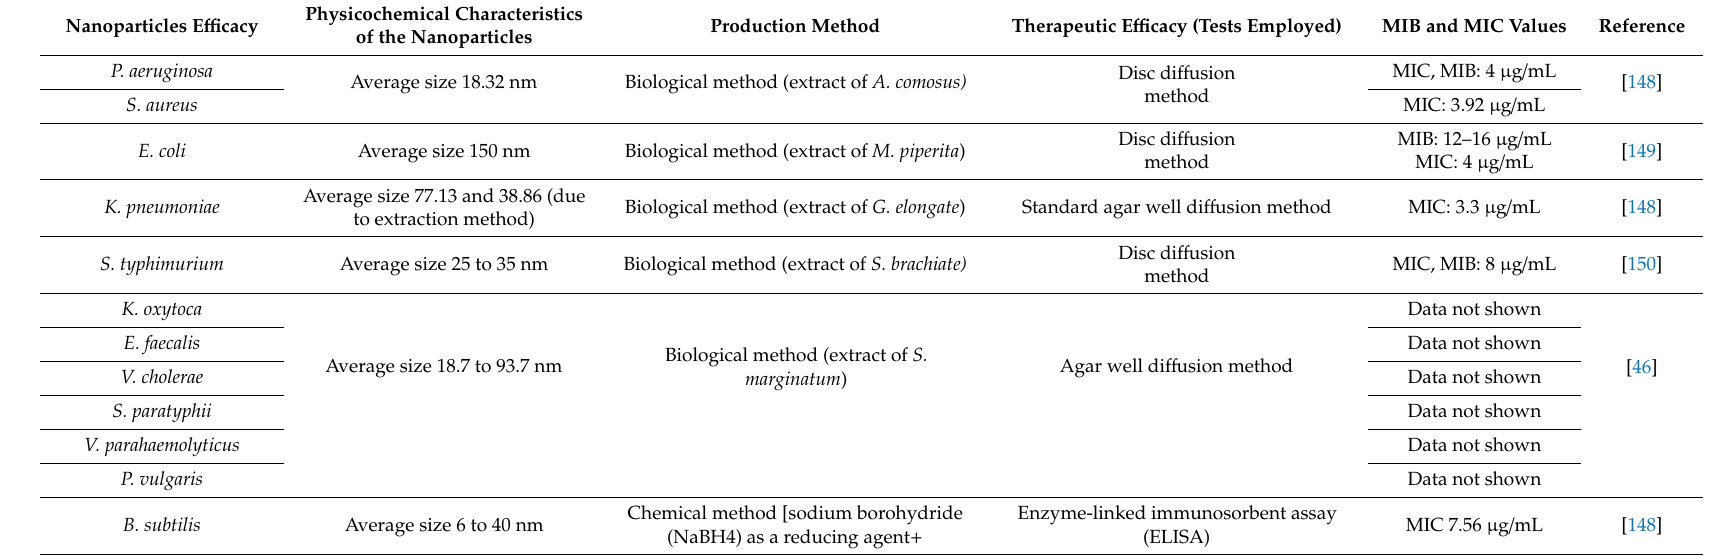
Table 4. Antibacterial applications of Au-based nanoparticles, with respective minimum inhibitory concentration (MIC) and minimum bactericidal concentration (MBC)